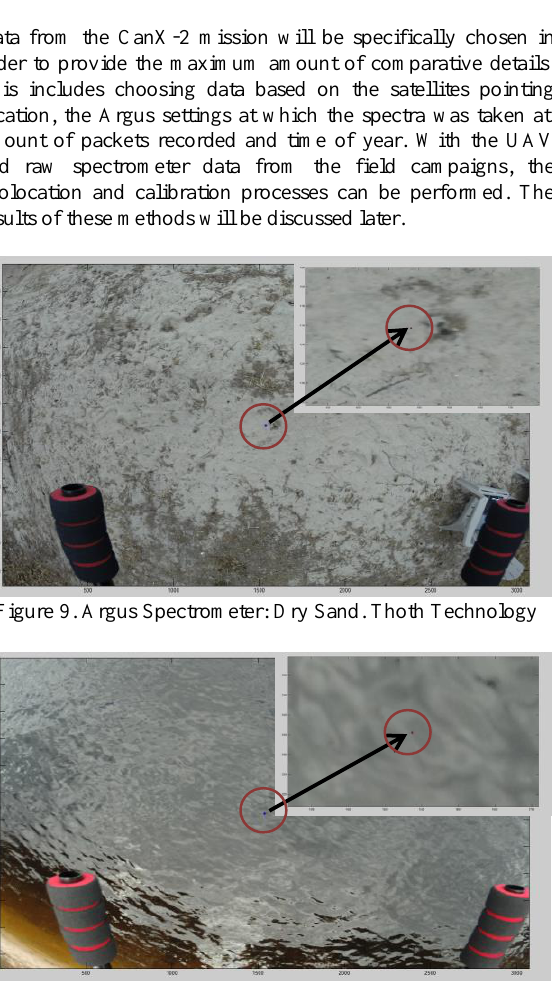
Figure 10. Argus Spectrometer: Lake. Thoth